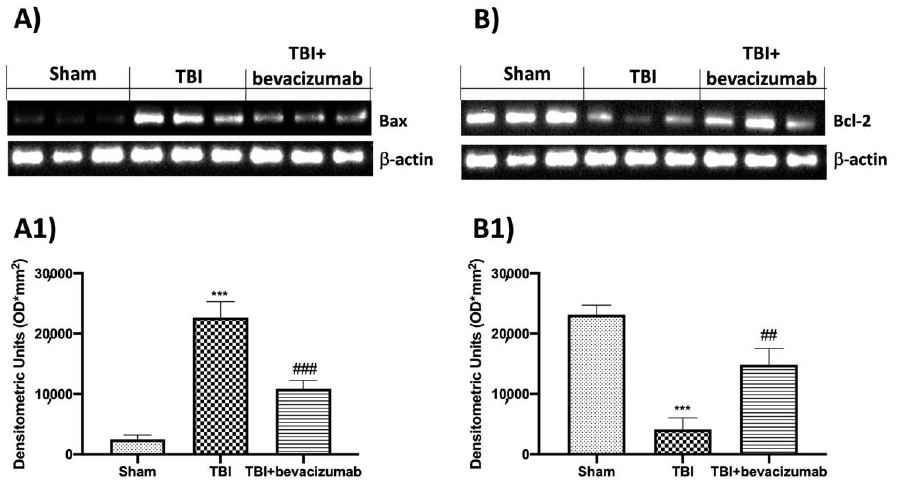
Figure 7. Effects of bevacizumab on Bax and Bcl-2 24 h after TBI. Representative Western blots for Bax ( A , A1 ) and Bcl-2 ( B , B1 ) expression were performed. Data show one representative blot from three independent experiments with similar results. Data are expressed as mean ± SD from n = 5 mice/group. *** p < 0.001 vs. Sham; ## p < 0.01 and ### p < 0.001 vs.